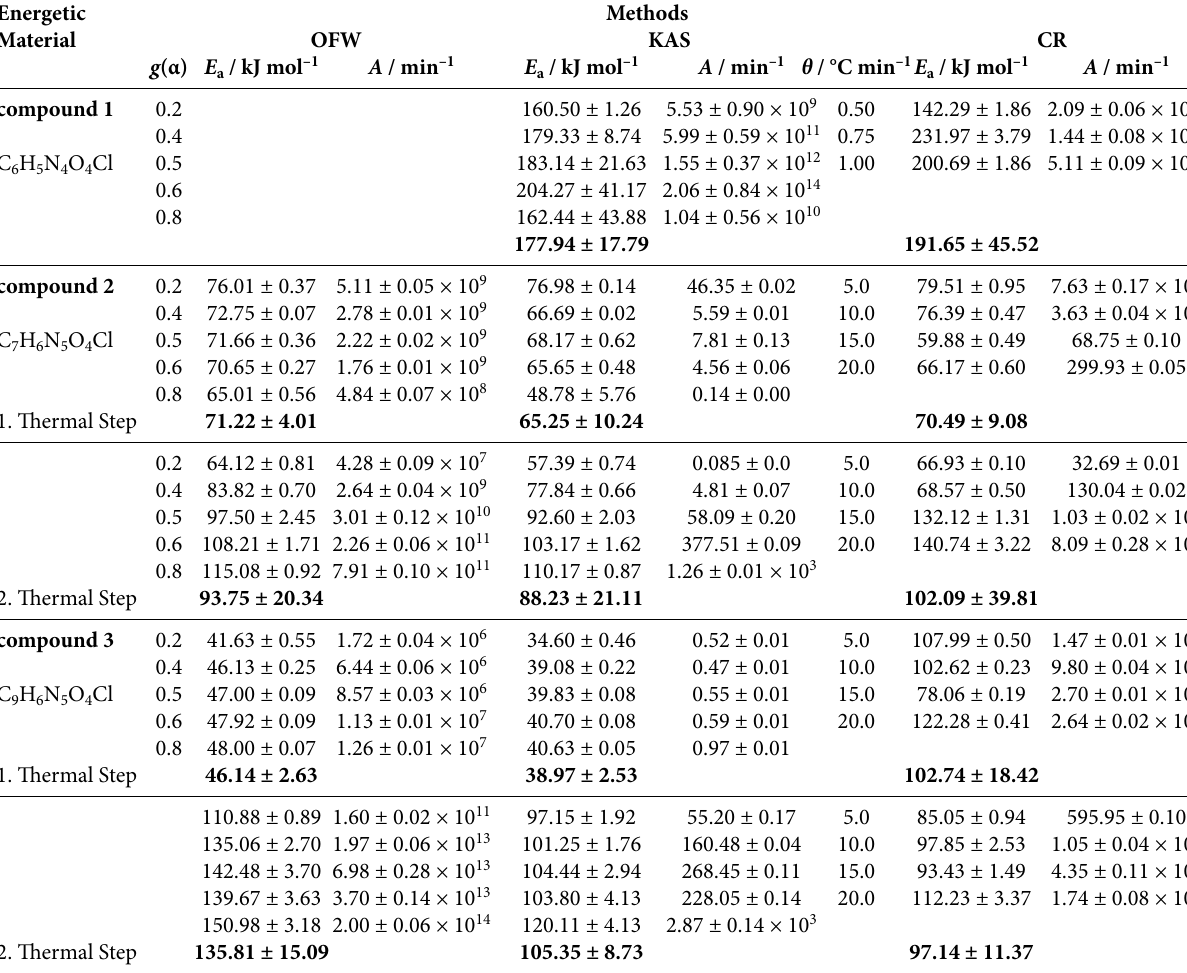
Table 5. The thermokinetic analysis results of energetic materials.